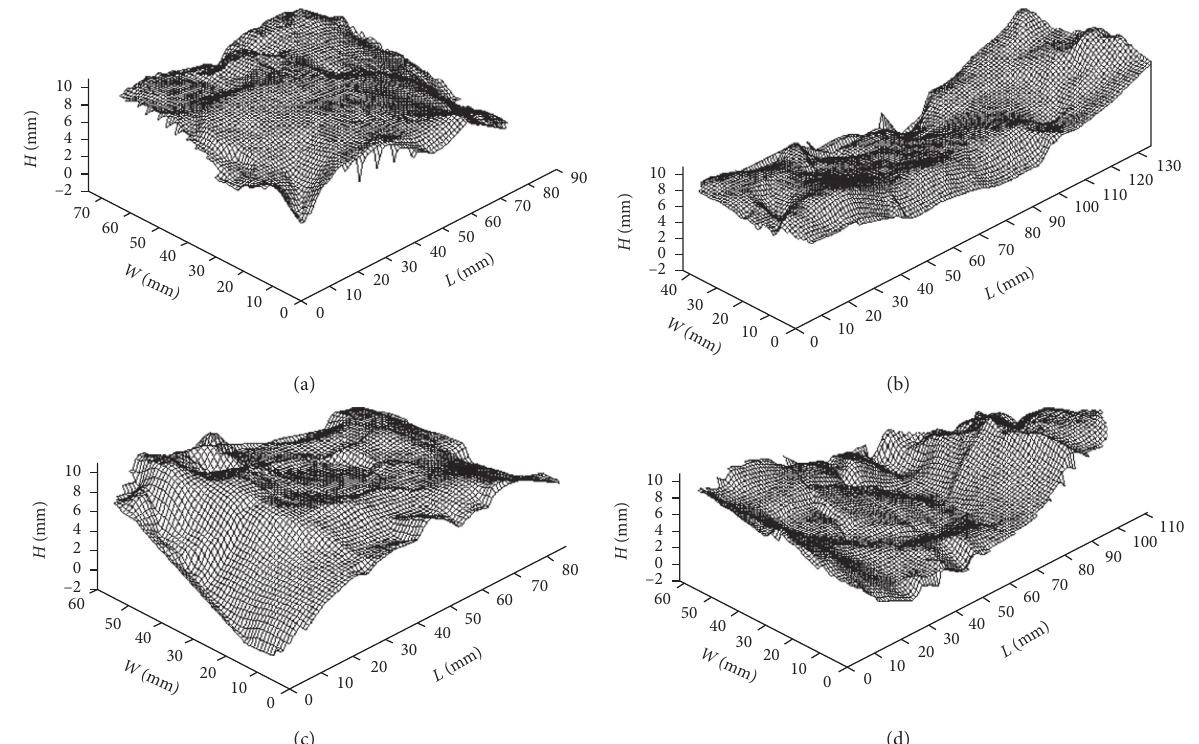
Figure 2: 3D topography of joint surfaces in each group. (a) Specimen 1. (b) Specimen 2. (c) Specimen 3. (d) Specimen 4.